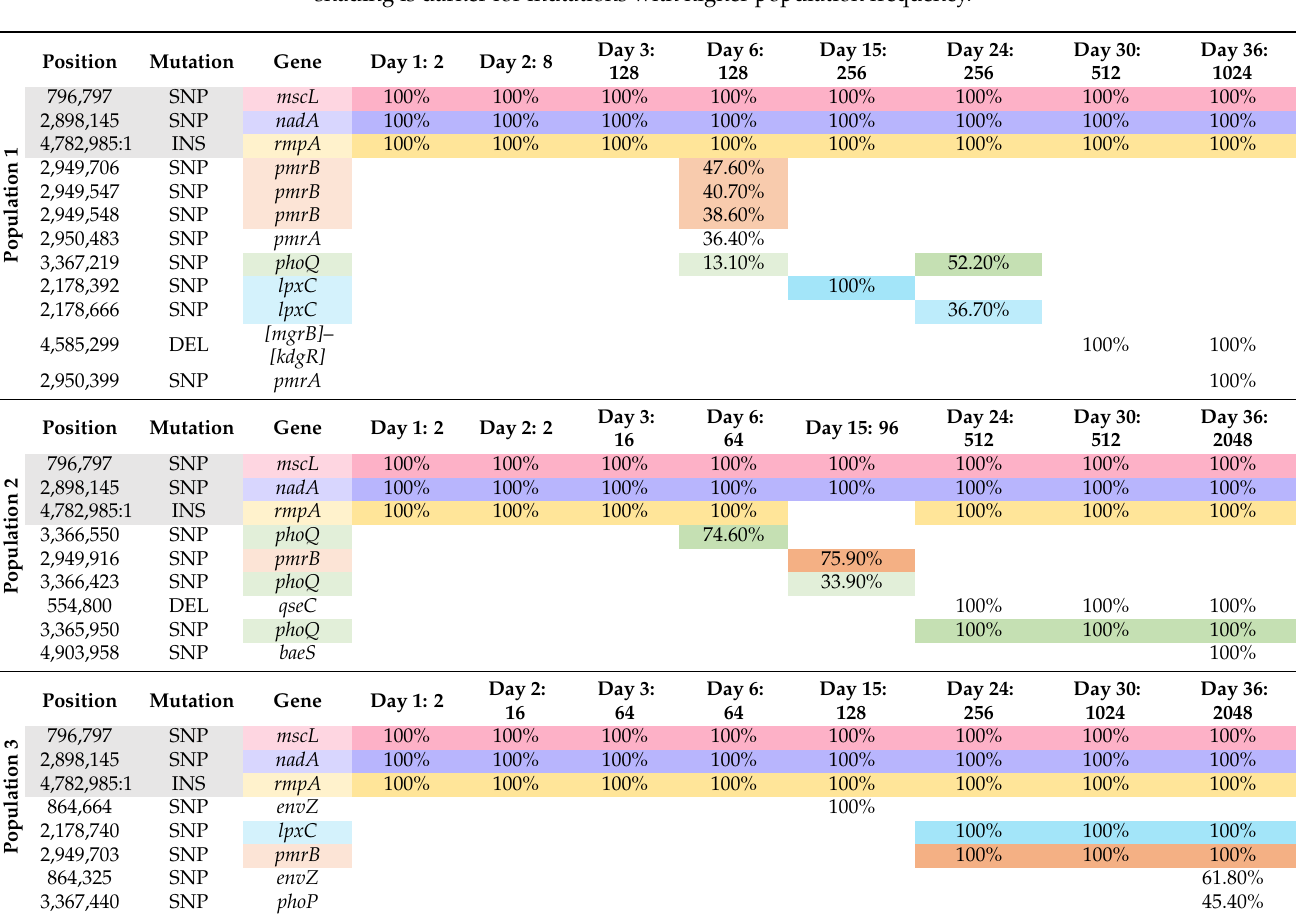
Table 2. Timepoint and MIC of acquired COL-R mutations in biofilm evolved KP populations. COL-R mutations are represented for each individually evolved KP population with colistin MIC ( µ g/mL) and population frequency. Mutations with shared gene positions between populations are shaded gray. Shared mutations in genes that are acquired in independently evolved populations are color- coded for comparison. Mutations unique to individual populations are in white background. The shading is darker for mutations with higher population frequency.